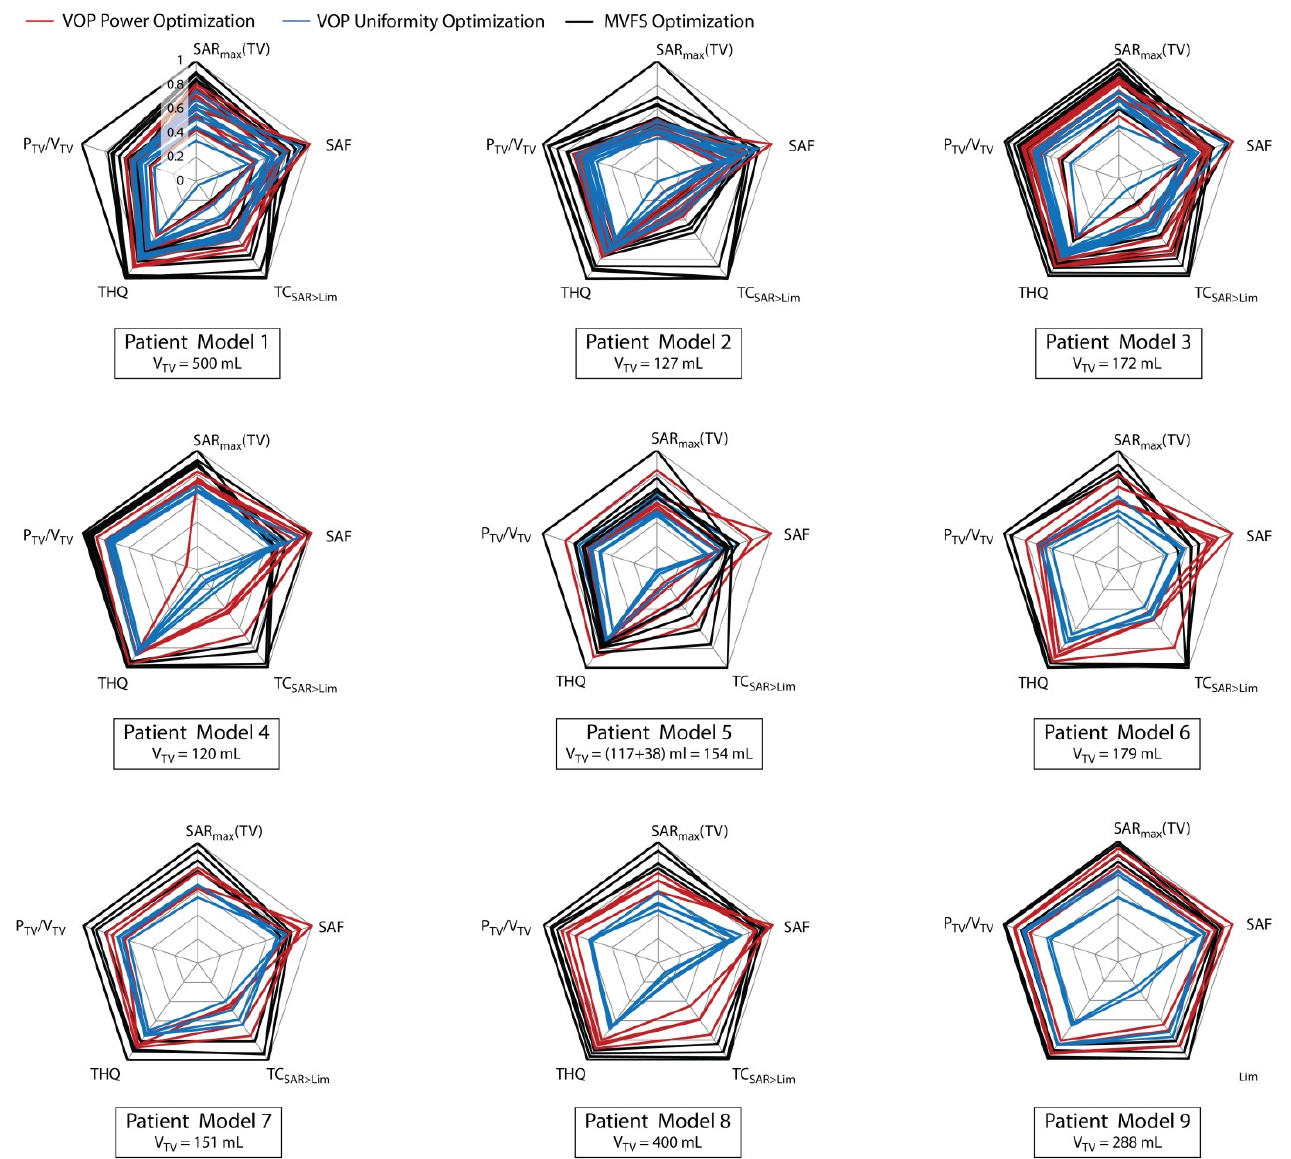
Figure 4. Comparison of all hyperthermia treatment planning results contrasted by optimization algorithm: red—VOP power optimization, blue—VOP uniformity optimization, black—MVFS optimization. All metrics are normalized to the respective inter-algorithm, inter-array maximum for each patient model.